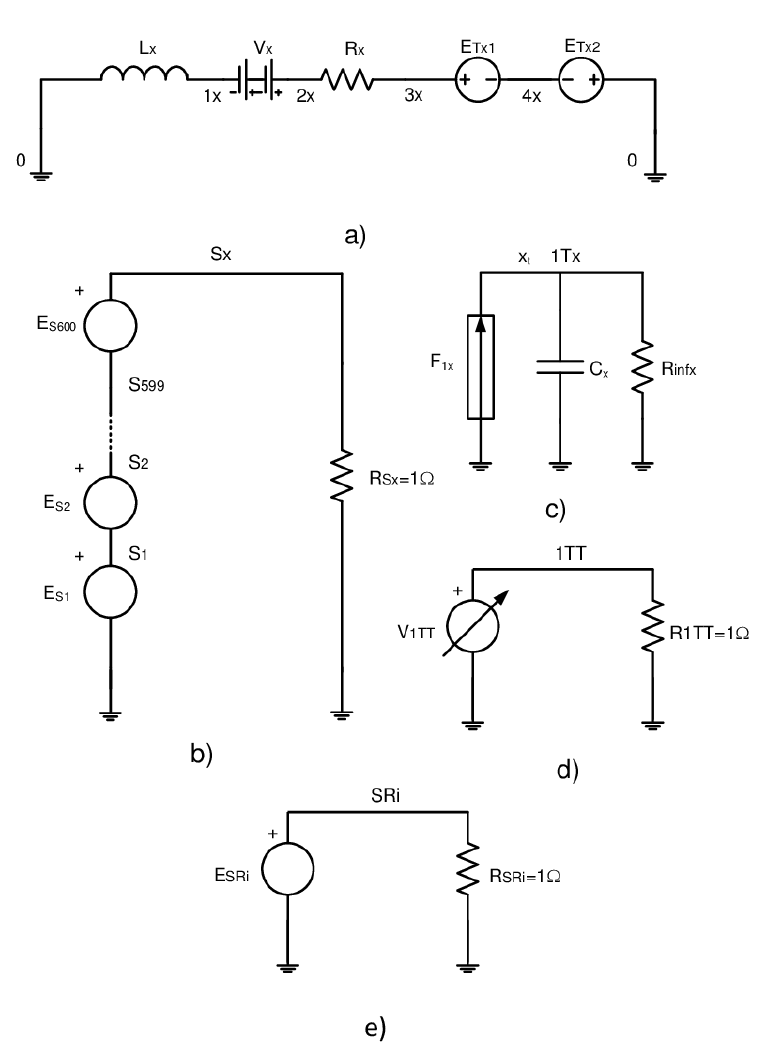
Figure 5 Network model, in x direction, of AFM on graphite. a) Main circuit, b) auxiliary circuit to obtain the force from Lennard-Jones potential, c) auxiliary circuit to obtain xt, d) auxiliary circuit to obtain the time, and e) auxiliary circuit to obtain the square of the distance between the AFM tip and the carbon